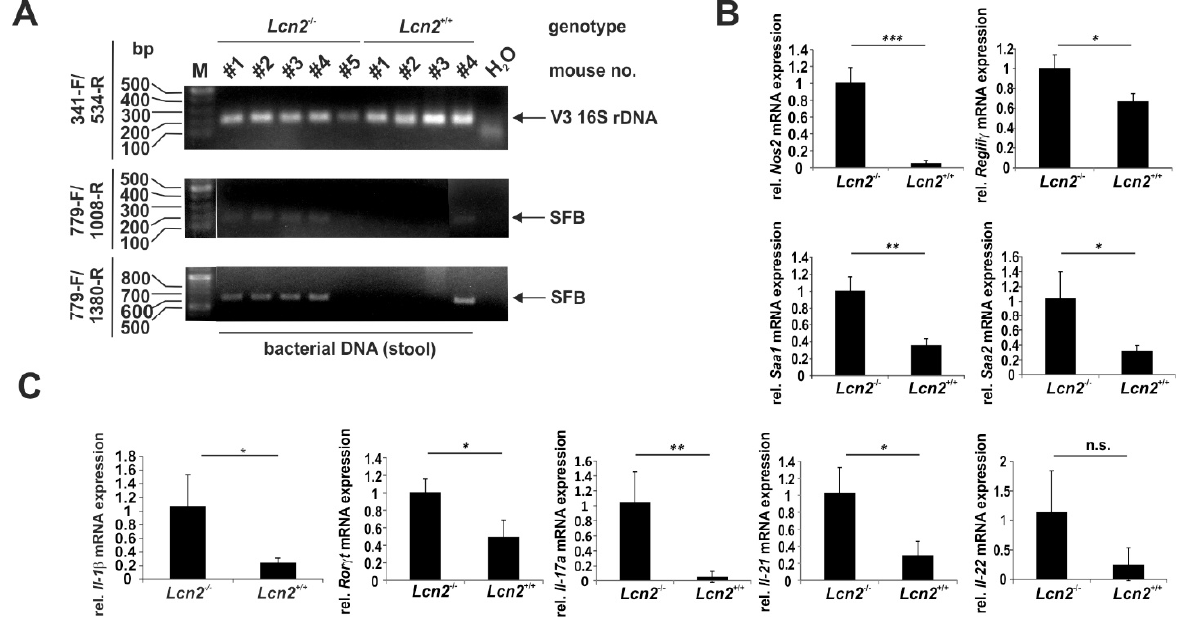
Figure 11. Proof and consequences of elevated quantities of segmented filamentous bacteria (SFB) in Lcn2 -/- mice. ( A ) DNA was extracted from the distal ileal content of wild type and Lcn2 -/- mice and analyzed by PCR for bacterial V3 16S- and SFB-specific 16S rRNAs. ( B , C ) Quantitative mRNA expression analysis of Nos2 , RegIII γ , Saa1 , Saa2, Il-1 β , Ror γ t, Il-17a , Il-21 , and Il-22 in the distal small intestine of wild type ( Lcn2 +/+ ) and Lcn2 null mice (each n = 4). Relative mRNA expression of respective genes was done by RT-qPCR and normalized to β -actin . Primers used are given in Supplementary Table S1. *: p < 0.05, **: p < 0.01, ***: p < 0.001.